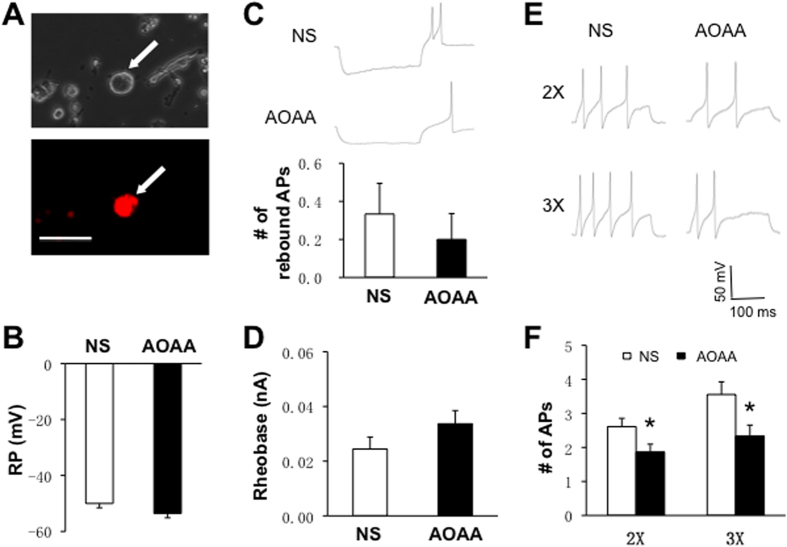
Inhibition of CBS by AOAA reduced neuronal hyperexcitability.(A) Representative DRG neuron retrogradely labeled by 1,1′-dioleyl-3,3,3′,3-tetramethylindocarbocyanine methanesulfonate (DiI) viewed under fluorescence microscope (bottom) and bright field (top). Scale bar = 50 μm. (B) Compared with the NS group, there was no significant change in resting membrane potential (RP, p > 0.05). (C) There was no significant difference of numbers of rebound action potentials (APs) between NS and AOAA group (p > 0.05). (D) Compared with the NS group, there was no significant change in rheobase (p > 0.05). (E) The representative traces of action potentials (APs) induced by 300-ms depolarizing current injection at 2× rheobase (top) and 3× rheobase (bottom) in L5–6 DRG neurons from NS (left) and AOAA group (right) under current-clamp conditions. (F) AOAA treatment (intrathecally once per day for consecutive 7 days after NP-transplant) resulted in a significant decrease in the number of APs induced by a 2× and 3× rheobase current injection in L5–6 DRG neurons (*p < 0.05).